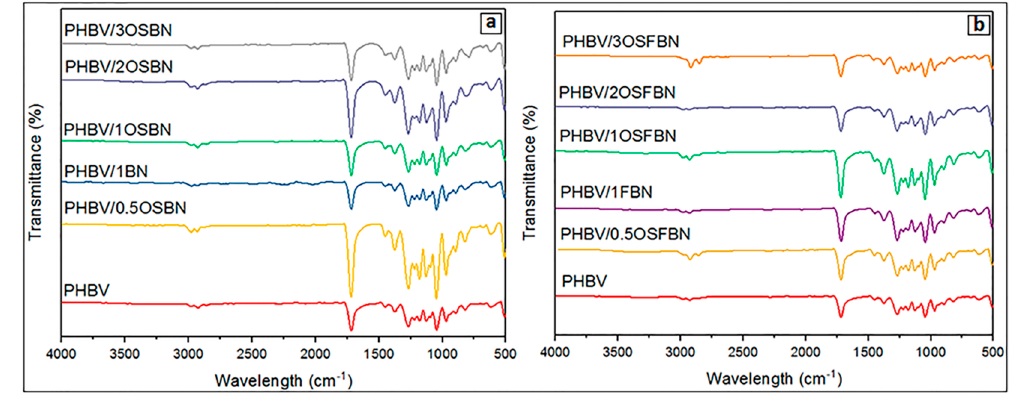
Figure 5. FTIR spectrum of nanocomposites ( a ) PHBV/BN ( b ) PHBV/FBN.